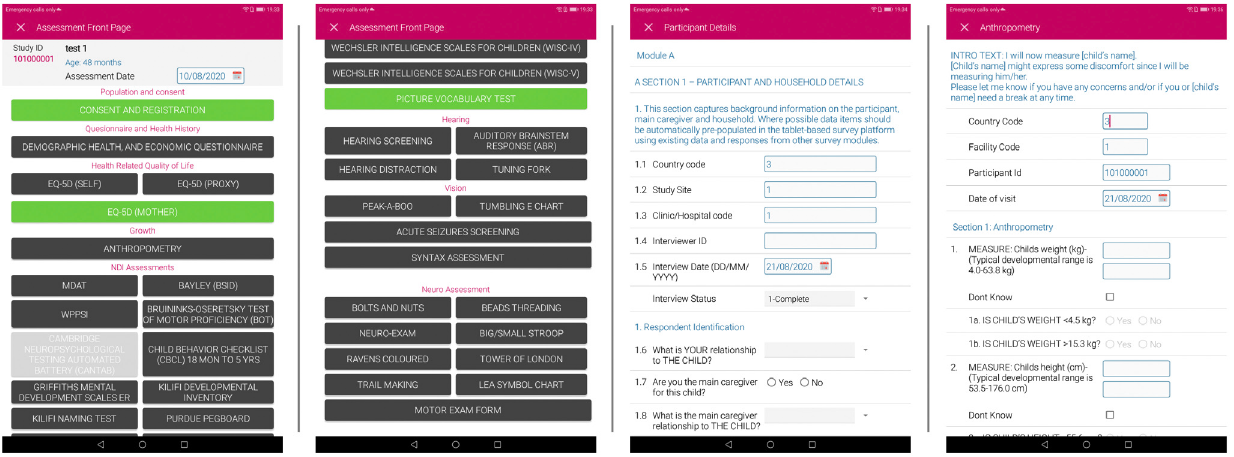
Figure 1. Screenshots from the customized data capture